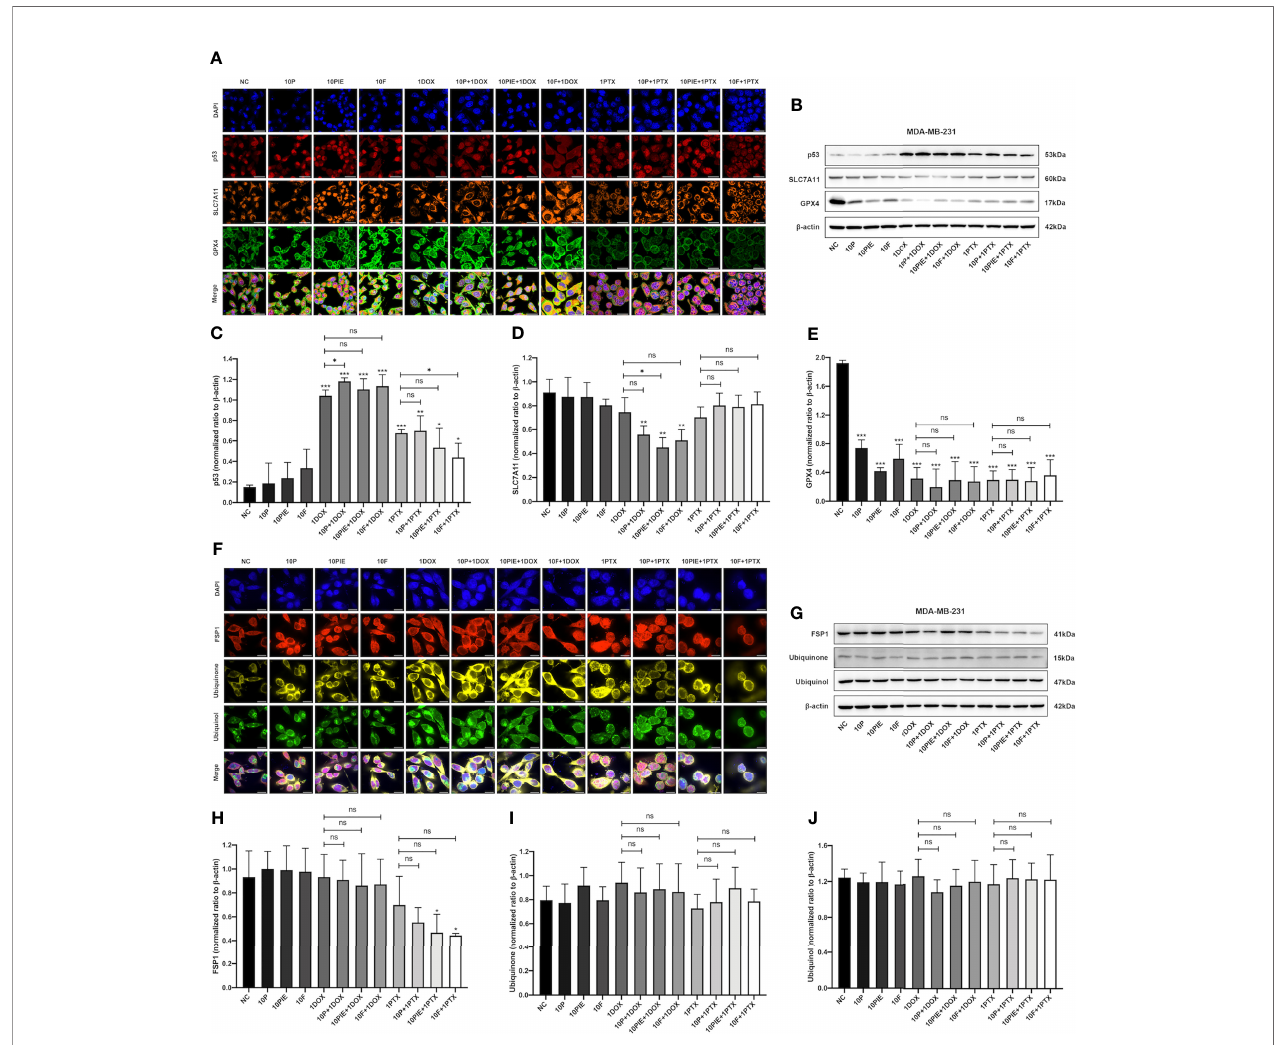
FIGURE 6 | Effects of propofol/PIE/fospropofol disodium with or without doxorubicin/paclitaxel on p53-SLC7A11-GPX4 and ubiquinone-FSP1-ubiquinol signaling pathways in MDA-MB-231 cells. The expression and subcellular localization of p53/SLC7A11/GPX4 (A) and FSP1/ubiquinone/ubiquinol (F) were determined using mIHC. DAPI was used to stain cell nuclei. Bar = 50 µm (A) and 14 µm (F) . The expression of p53/SLC7A11/GPX4 (B) and FSP1/ubiquinone/ubiquinol (G) were determined by western blotting. b -actin was used as the internal reference. The corresponding statistical analyses of western blotting bands of p53 (C) , SLC7A11 (D) , GPX4 (E) , FSP1 (H) , ubiquinone (I) and ubiquinol (J) were conducted and each experiment was repeated at least three times. ns, no signi fi cant difference. * P < 0.05, ** P < 0.01, *** P <